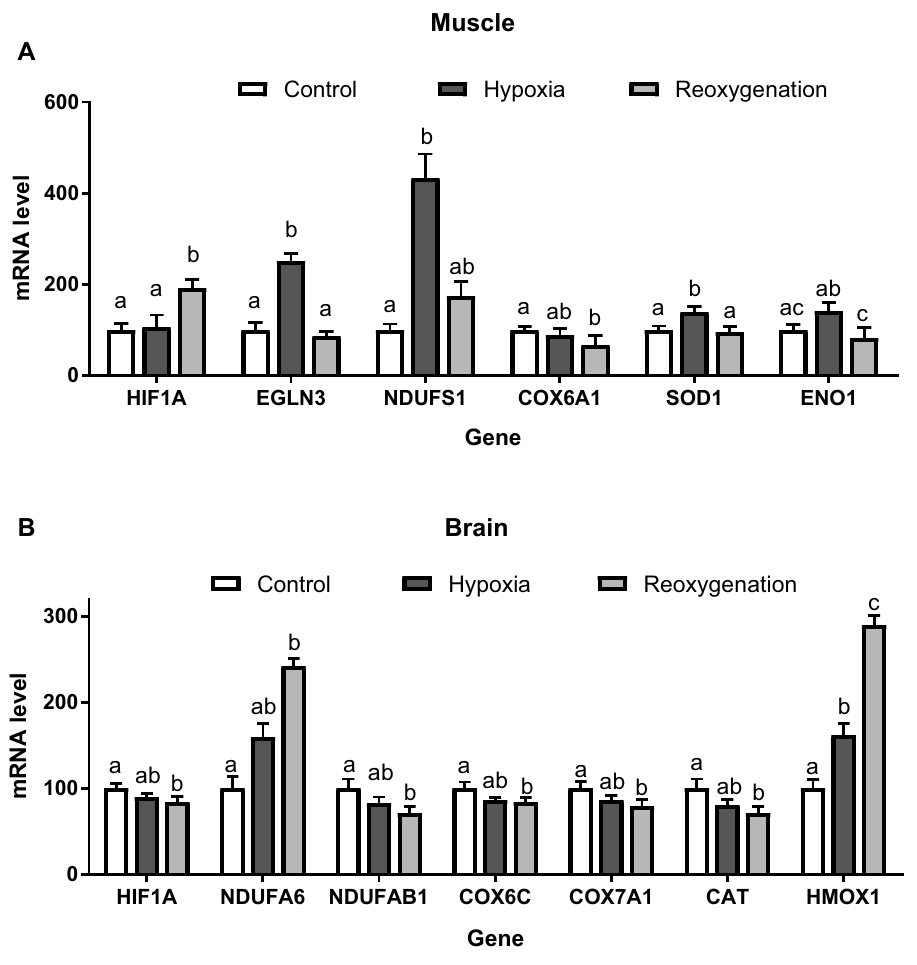
Figure 4. Effect of the H-R stress on mRNA expression of hypoxia-responsive genes in the isolated skeletal muscle and brain cells of S. scrofa. HIF1A—Hypoxia Inducible Factor 1 Alpha Subunit, EGLN3—Egl-9 Family Hypoxia Inducible Factor 3, NDUFS1—NADH: Ubiquinone Oxidoreductase Core Subunit S1, COX6A1- Cytochrome C Oxidase Subunit 6A1, SOD1- Superoxide Dismutase 1, HMOX1- Heme Oxygenase 1, ENO1- Enolase 1, NDUFA6—NADH: Ubiquinone Oxidoreductase Subunit A6, SDHC—Succinate Dehydrogenase Complex Subunit C, COX6C—Cytochrome c Oxidase Subunit 6C, COX7A1—Cytochrome C Oxidase Subunit 7A1, and CAT- Catalase. ( A ) skeletal muscle cells, ( B ) brain cells. Only the transcripts that showed significant ( P <0.05) changes in hypoxia and/or reoxygenation relative to the normoxic controls are shown. Letters indicate differences between the exposure conditions; columns that do not share a letter are significantly different ( P